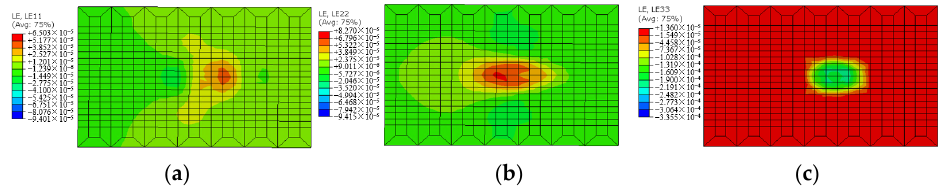
Figure 11. The cloud of the dynamic strains of ART pavement at the speed of 10 km/h. ( a ) Longitu- dinal. ( b ) Transverse. ( c ) Vertical.